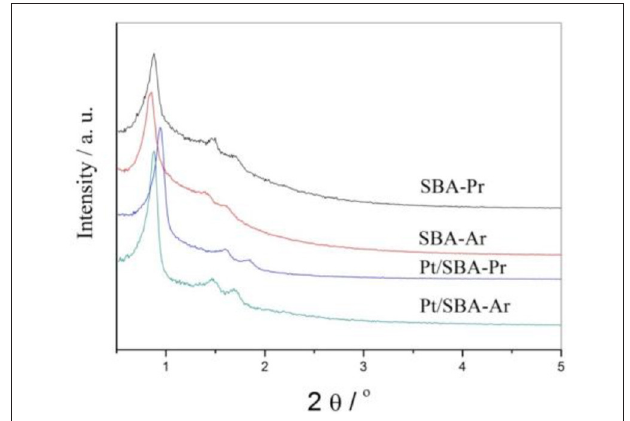
FIGURE 1 | SAXRD patterns of the catalyst